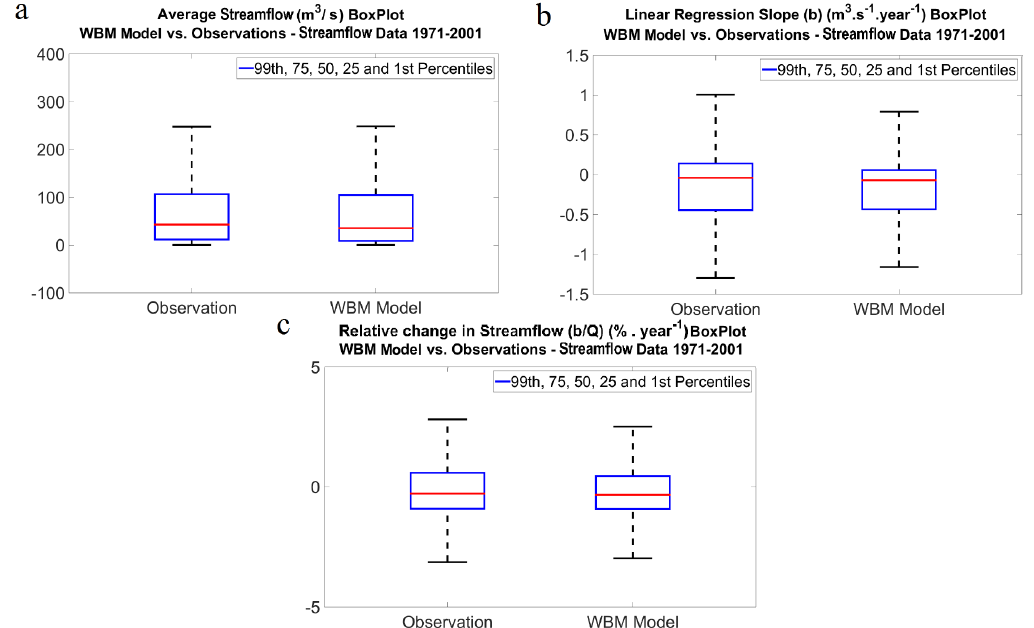
Figure 2 . WBM model versus observations streamflow data 1971–2001 boxplots for Coterminous US—Log of annual-averaged daily streamflow map for observations ( a ), Slope of change in streamflow map for observations ( b ) and relative change in annual-averaged daily streamflow map for observations ( c ). Values larger than 99 th and smaller than 1 st percentile of the data (considered as the outliers) have been excluded from the plots. The boxplots show good agreement between the observations and WBM model outputs for the relative change in